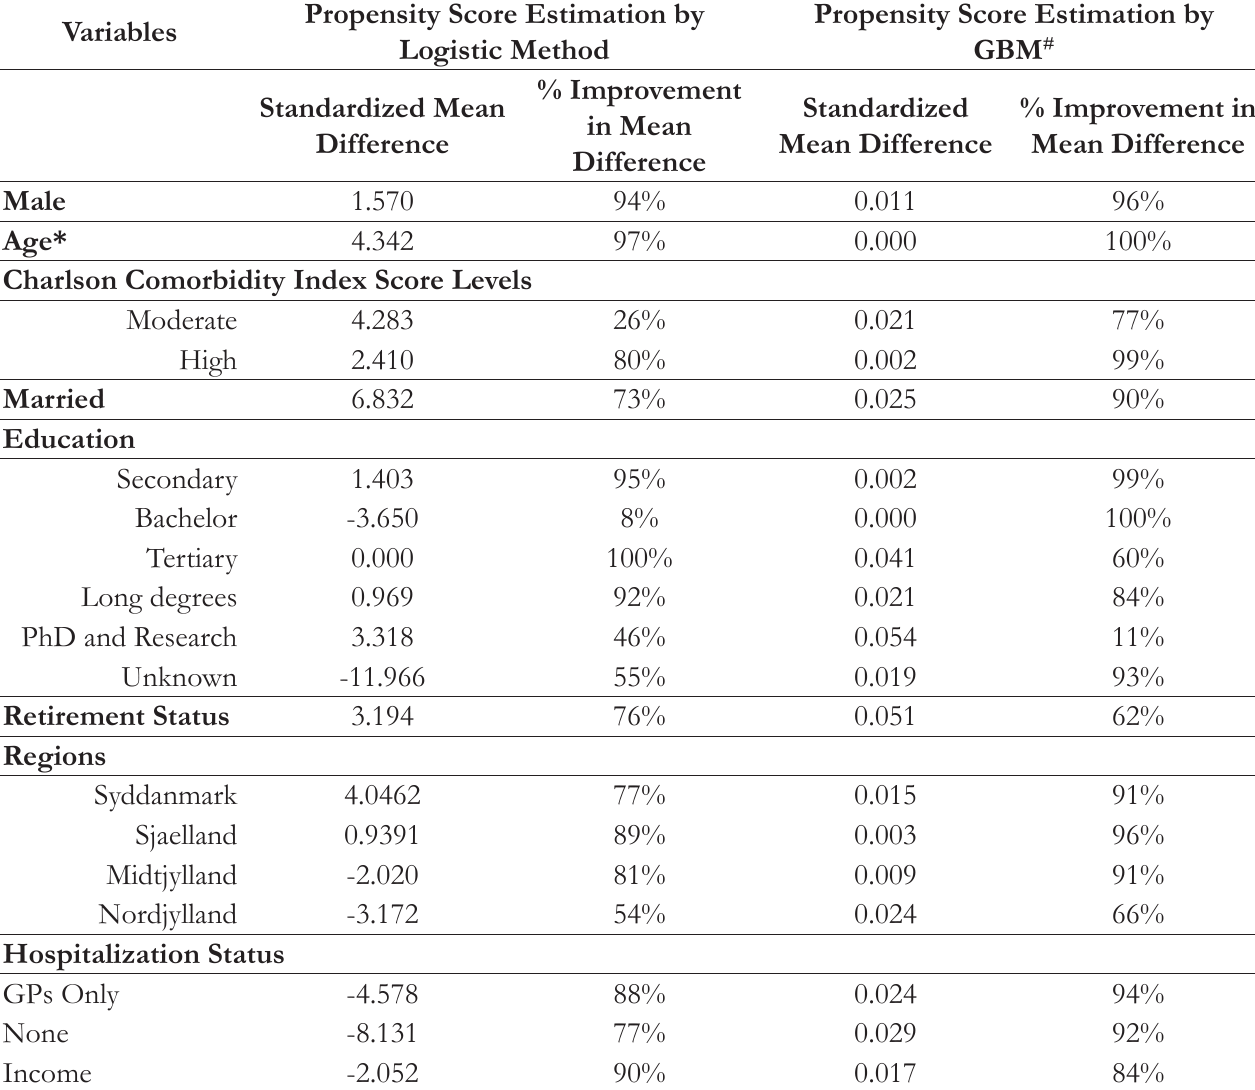
Propensity Score Estimation by